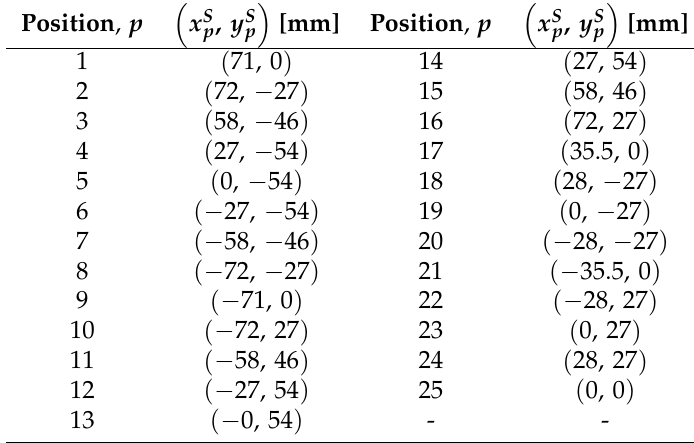
, (cid:101) ε S I = 32.04 ε 0 2 π f 0